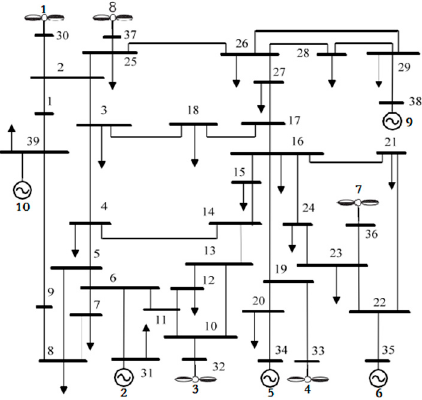
Figure 4. Structure of IEEE-39 bus system integrated with wind generators.